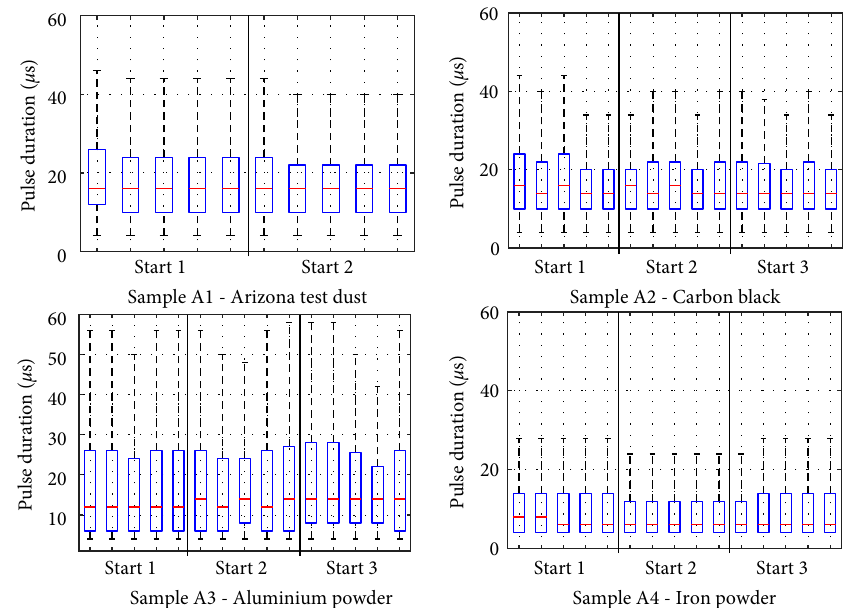
Figure 12: Median values of pulse duration during insulation breakdowns caused by different types of particles, at a fixed concentration of 150